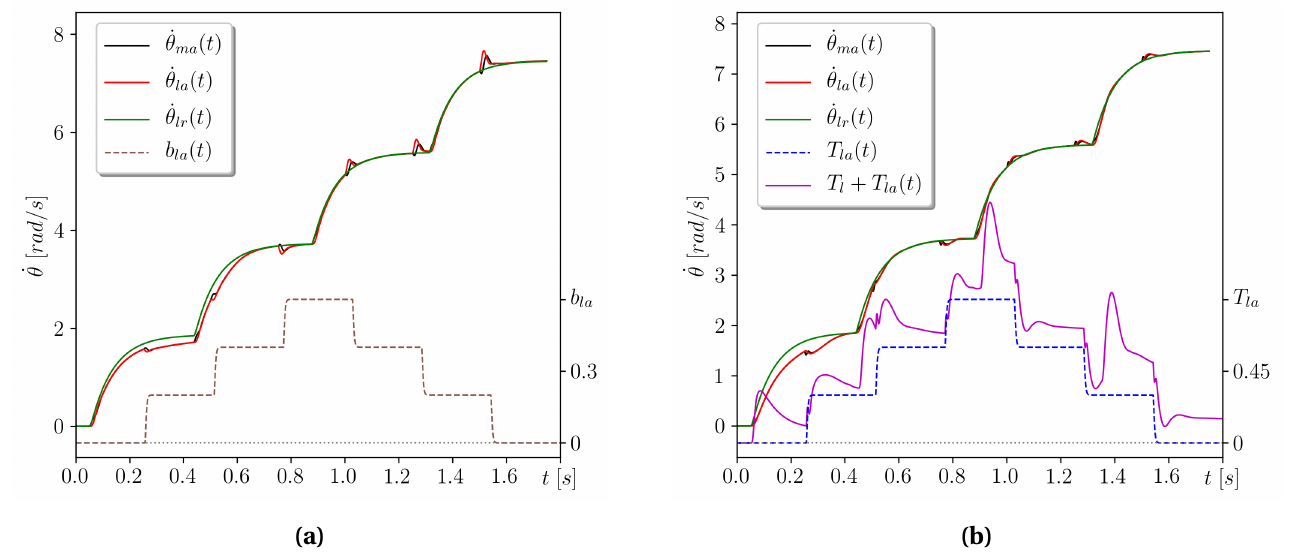
Figure 8. The closed-loop reference model control system response at the presence of the disturbed b la ( t ) ( a ) and T la ( t ) ( b ) and an adaptive PID regulator with PI compensation of error dynamics (low frequency)—see case B in the block diagram in Figure 4.